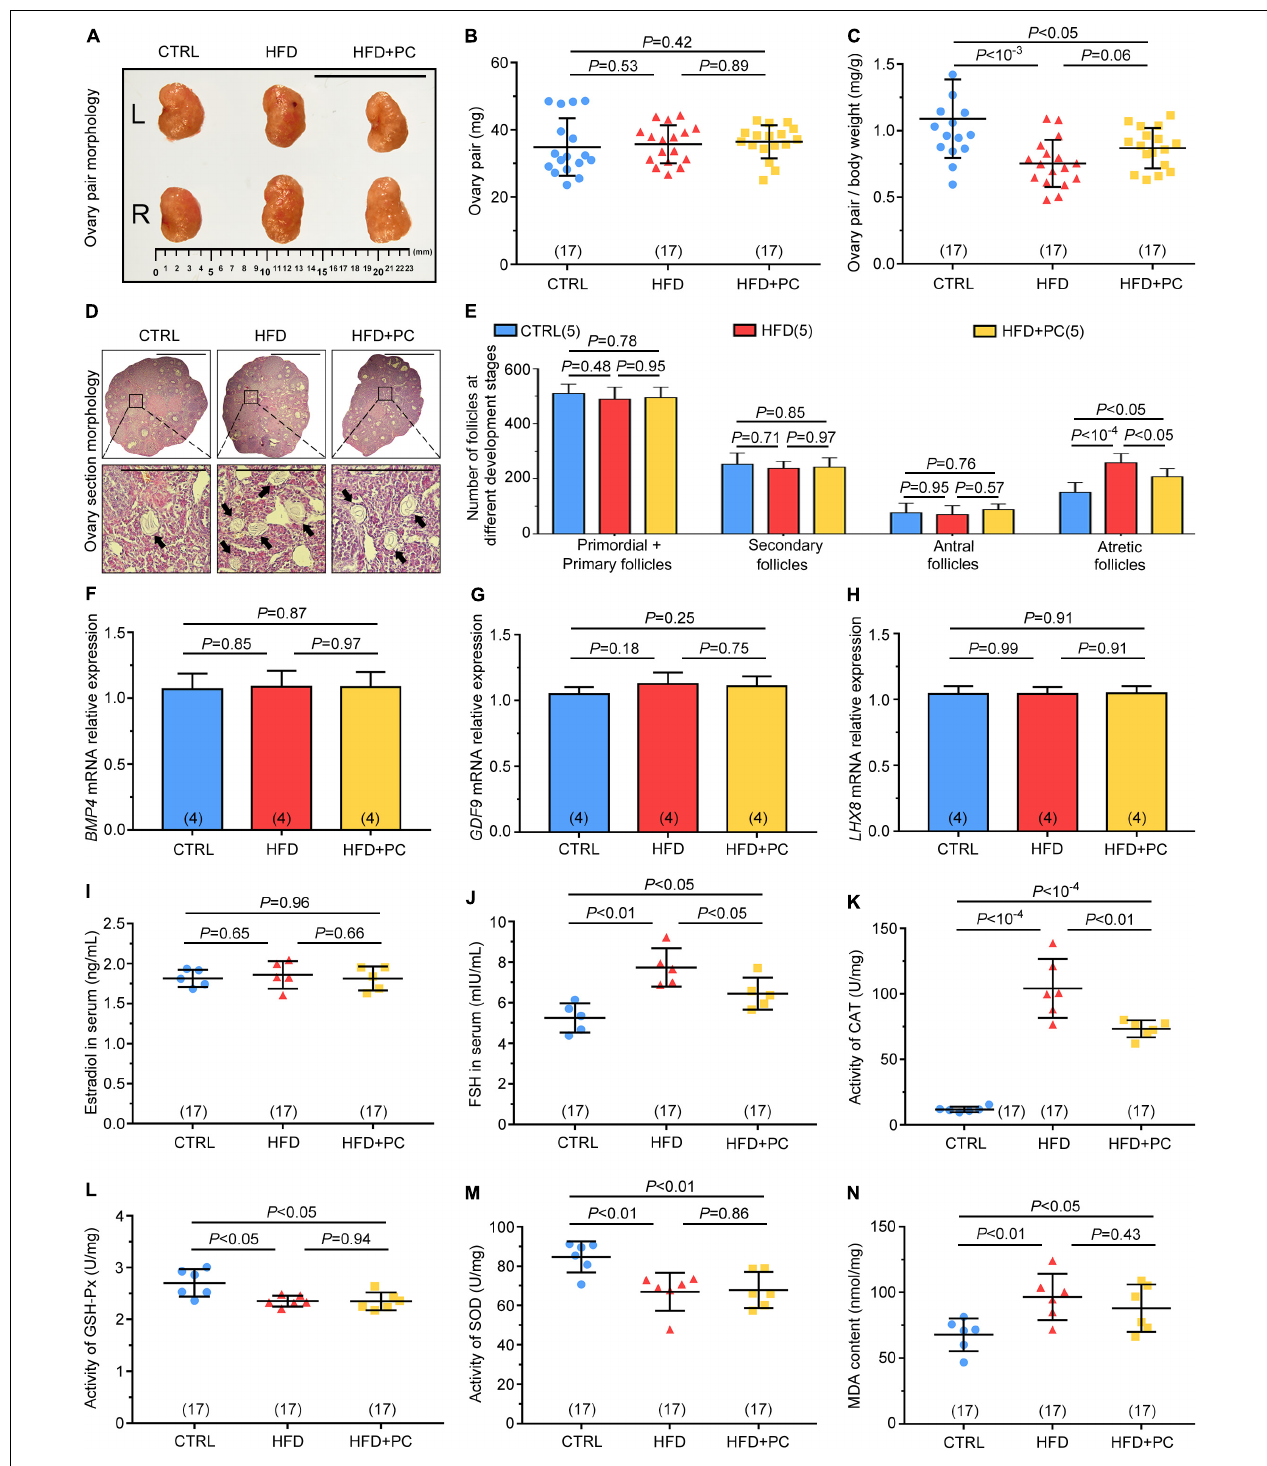
FIGURE 3 | PC promoted follicular development and reduced CAT and FSH levels in obese mice. (A) Macroscopic representations of the ovaries, scale bar = 10 µ m. (B) Ovary-pair weights. (C) Ovary-pair ratio coefficients. (D) Typical histological image of H&E-stained follicles, scale bar = 50 µ m, with black arrows indicating atretic follicles. (E) The statistics for follicles at different developmental stages in the ovaries. (F) Relative expressions of BMP4 mRNA. (G) Relative expressions of GDF9 mRNA. (H) Relative expressions of LHX8 mRNA. (I) Estradiol levels. (J) FSH levels. (K) CAT activities. (L) GSH-Px activities. (M) SOD activities. (N) MDA contents. Data are expressed as mean ± SD and were compared by one-way ANOVA and Newman–Keuls post hoc tests. The number of ovary pairs in each group is shown in parentheses.